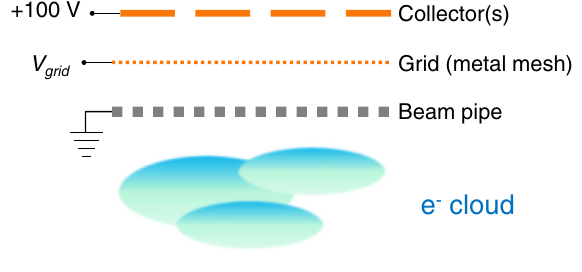
FIG. 1. Idealized diagram of a retarding field analyzer.